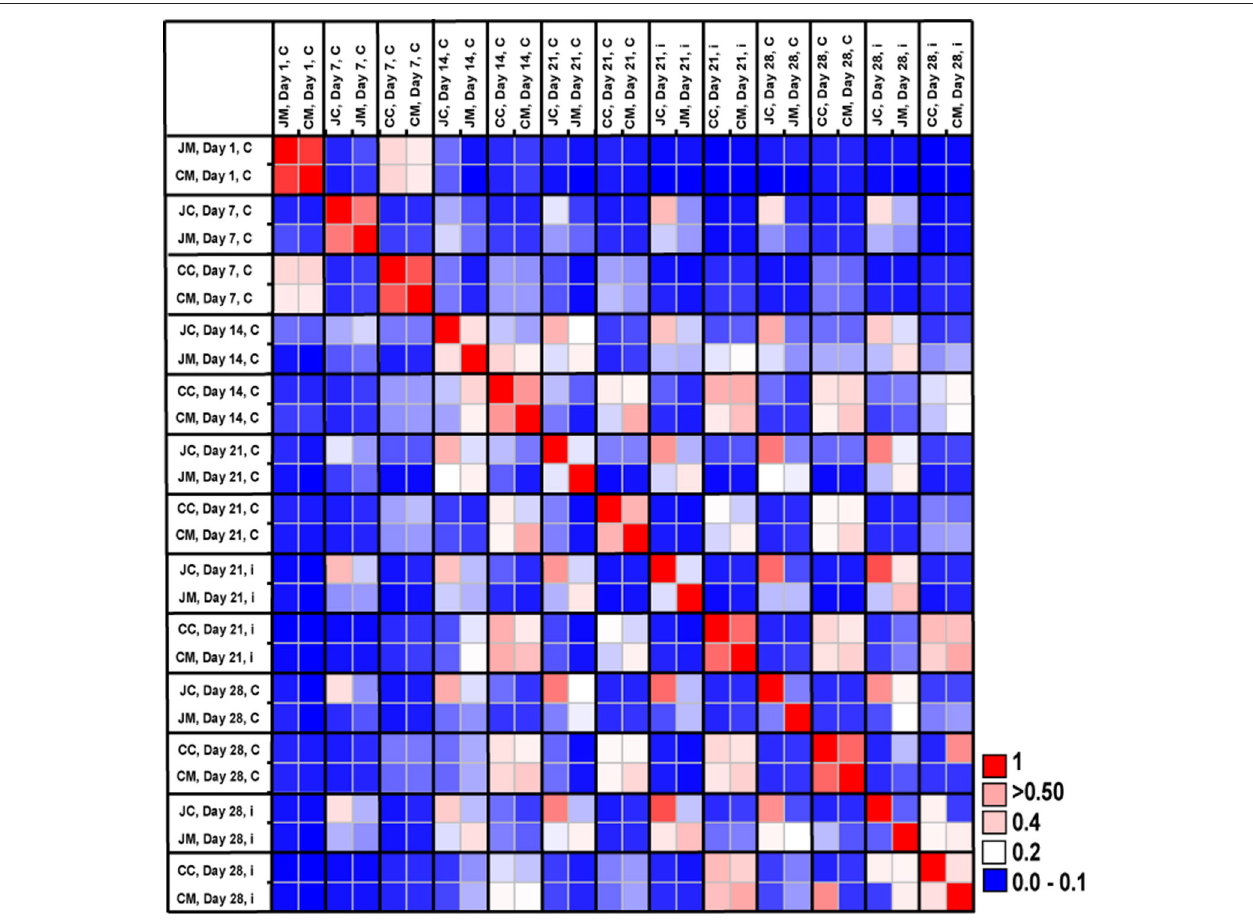
FIGURE 5 | Microbial community similarity between all samples calculated with Bray-Curtis similarities, which displays the similarity results between the control and infected groups according to age and gut sites. JM, jejunal mucosa; JC, jejunal content; CM, cecum mucosa; CC, cecum